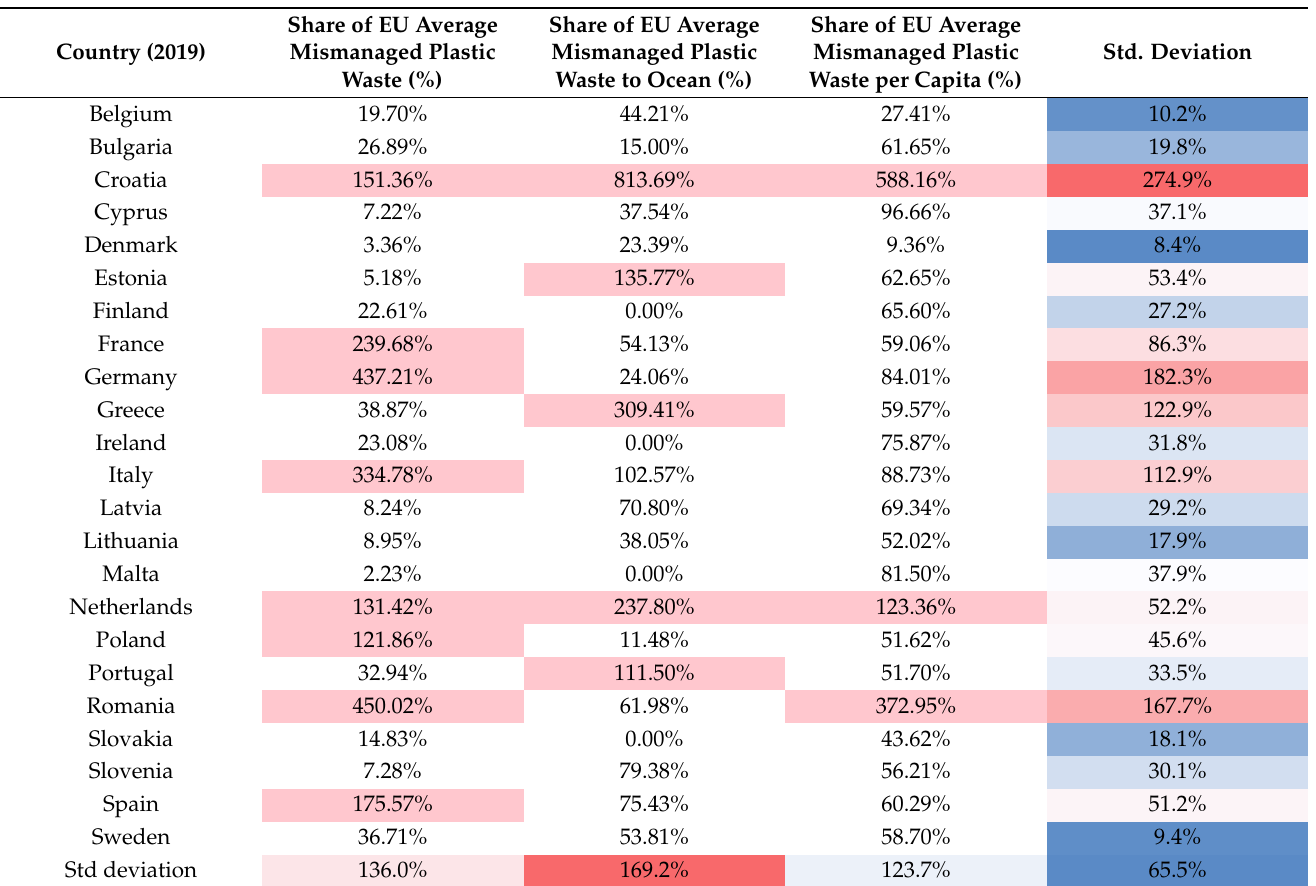
Table 4. Analysis of the degree of regional disparity on policies to combat plastic water pollution in the